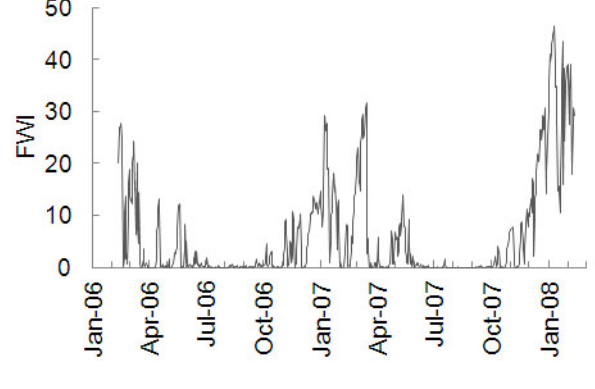
Fig. 5 . Calculated daily values of the Fire Weather Index (FWI) for the period February 11, 2006 to February 11,